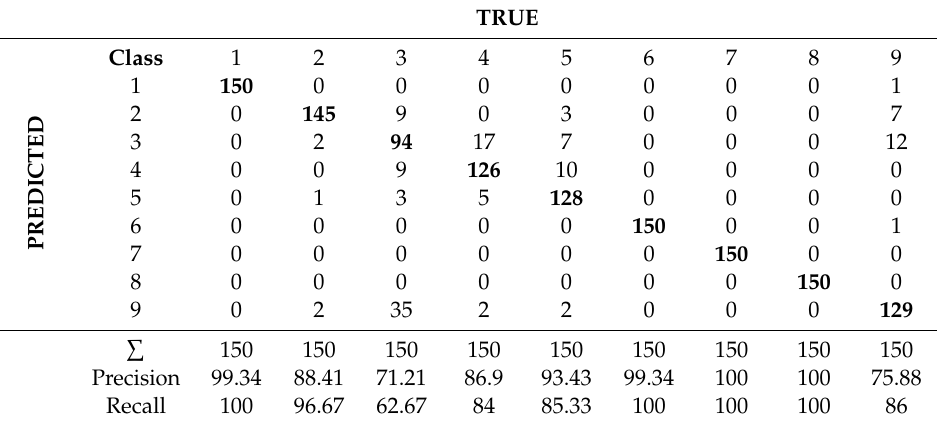
Table 3. Confusion matrix of sorting results into nine classes.